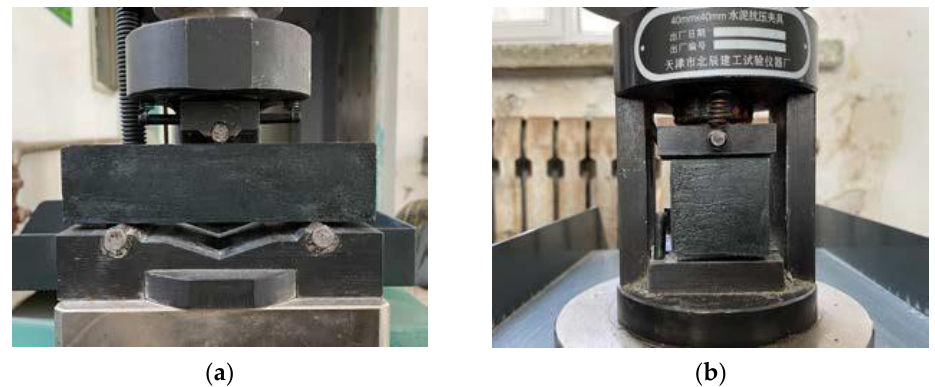
Figure 4. Strength test of geopolymer: ( a ) flexural strength; ( b ) compressive strength.